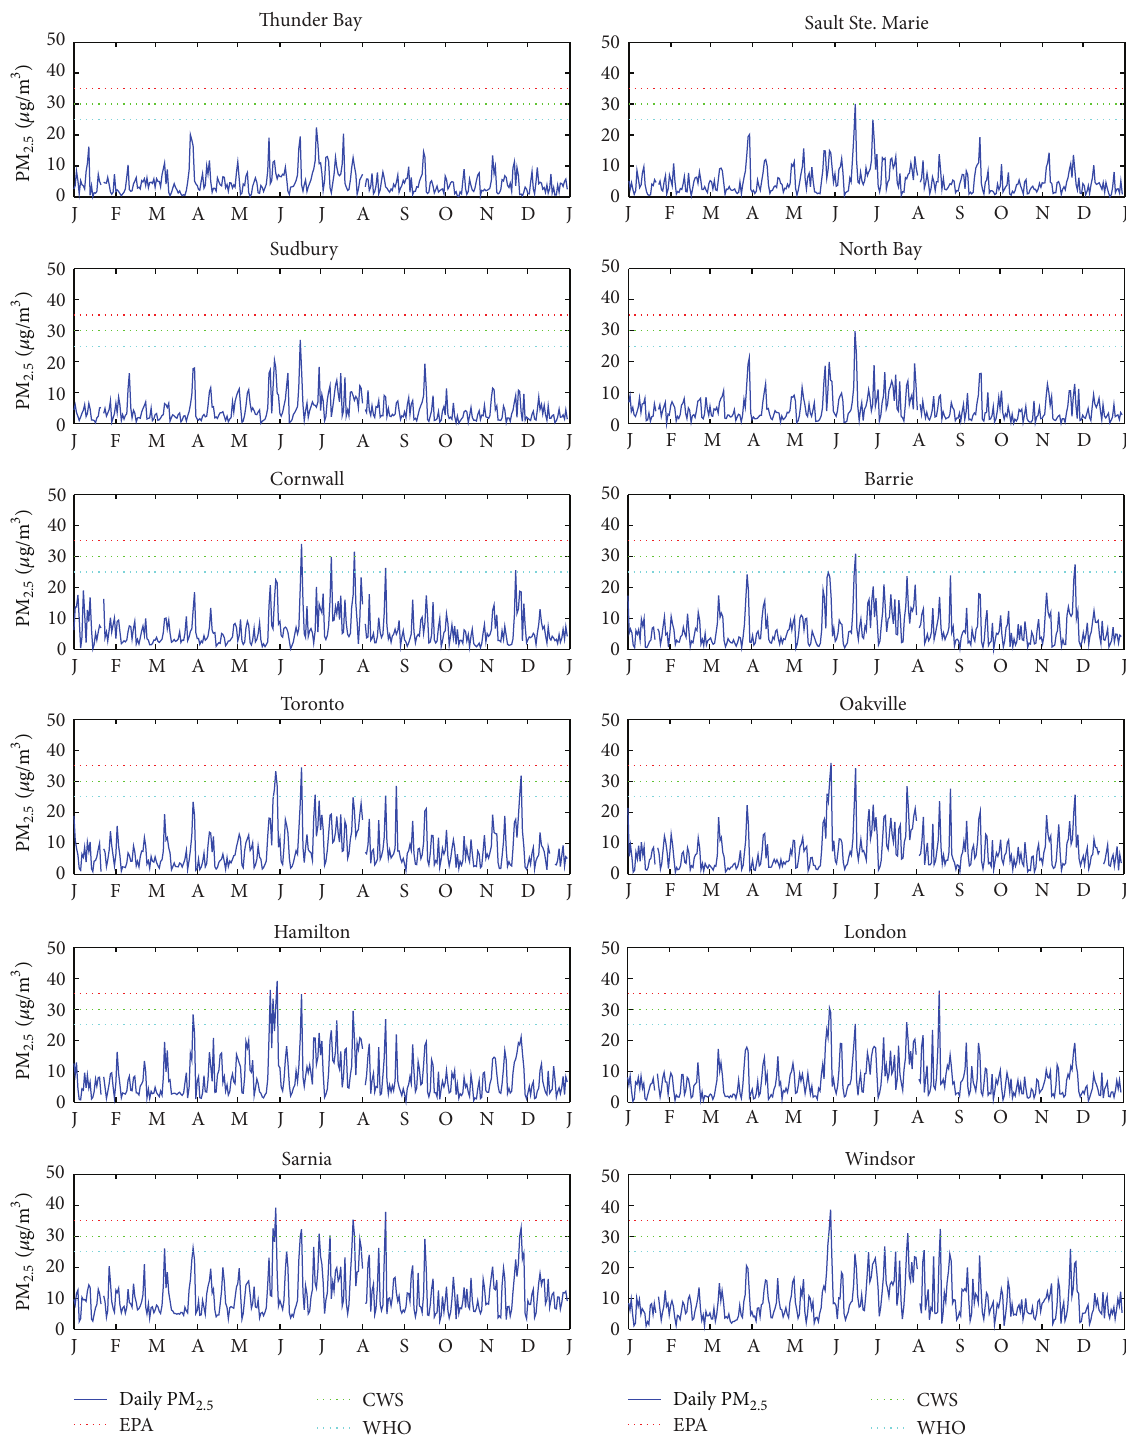
Figure 2: Daily variation of PM 2.5 at 12 cities in Ontario in 2006, with three 24-hour guidelines: 25 𝜇 g/m 3 by the World Health Organization (WHO) guideline, 30 𝜇 g/m 3 by the Canadian Wide Standards (CWS), and 35 𝜇 g/m 3 by the Environmental Protection Agency (EPA) of USA guideline. The 𝑥 -axis indicates months of the year by their initial letters. The cities are ordered by descending latitude (see Table 1 and Figure